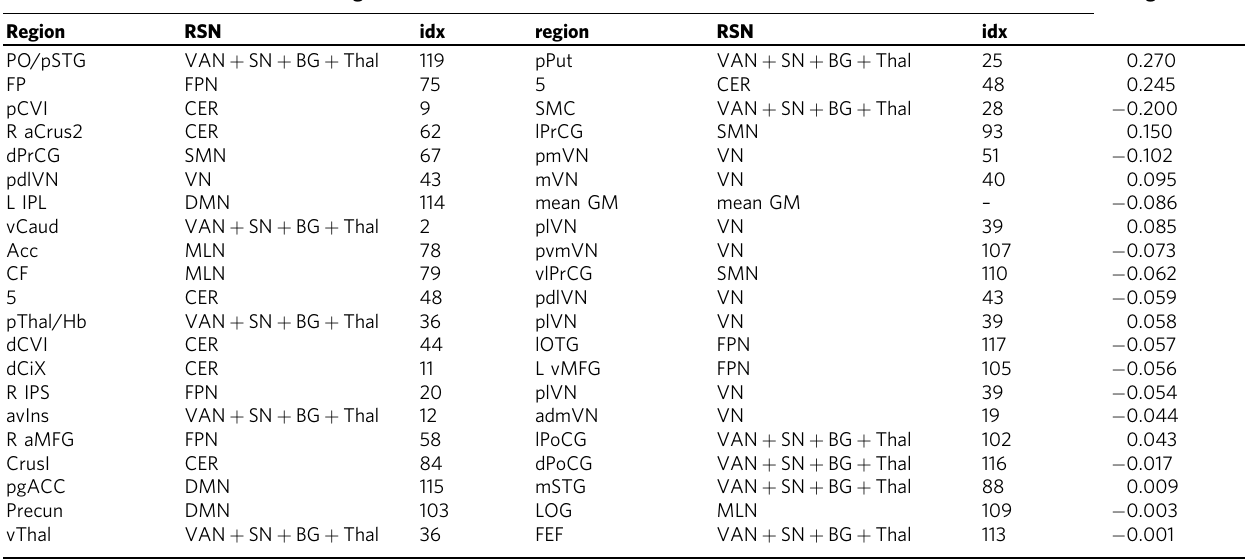
Table 2 Predictive connections of the RPN signature. Predictive connections between brain regions